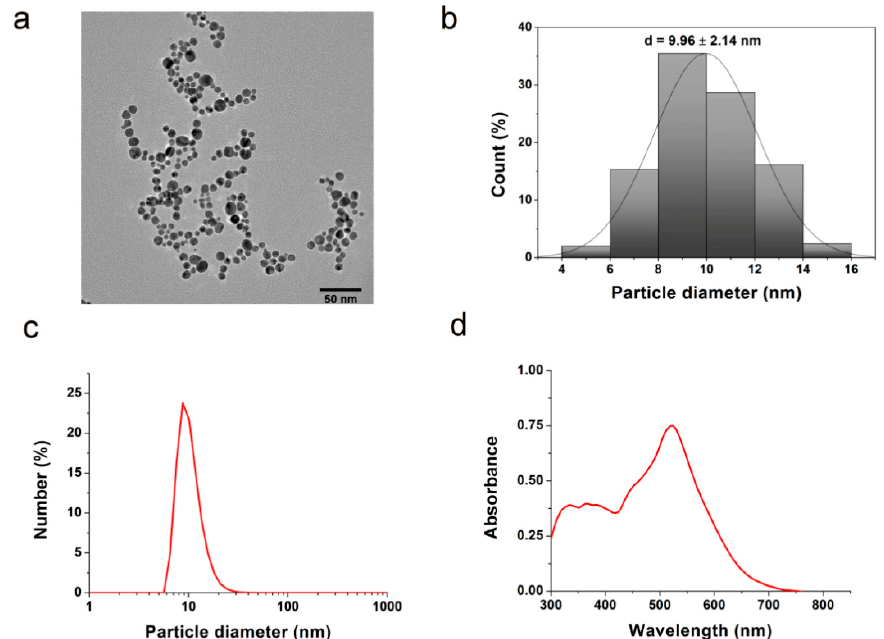
Figure 1. Characterization of gold nanoparticles. ( a ) The chemically synthesized citrate-coated gold nanoparticles (AuNPs) were visualized by transmission electron microscopy. The average diameter of the obtained AuNPs is around 10 nm according to ( b ) transmission electron microscope (TEM) image analysis and ( c ) dynamic light scattering (DLS). ( d ) The characteristic peak around 520 nm on the ultraviolet–visible (UV–Vis) spectrum suggests the presence of AuNPs in the solution.